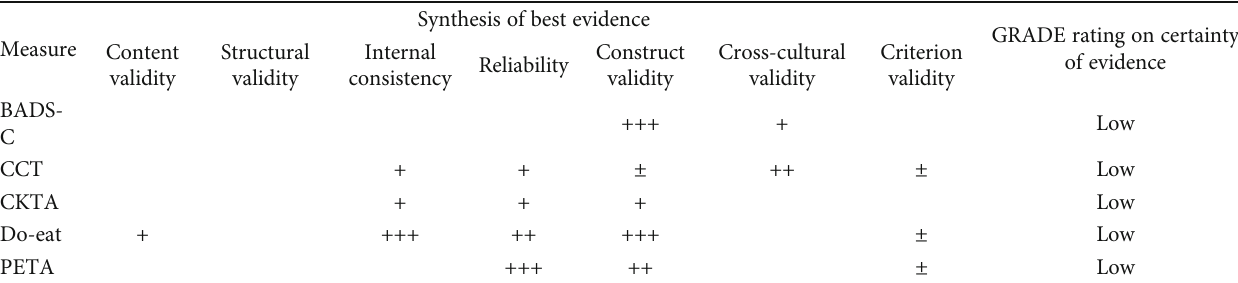
Table 4: Summary of synthesis of best evidence and GRADE rating on evidence certainty for the reviewed EF tools.